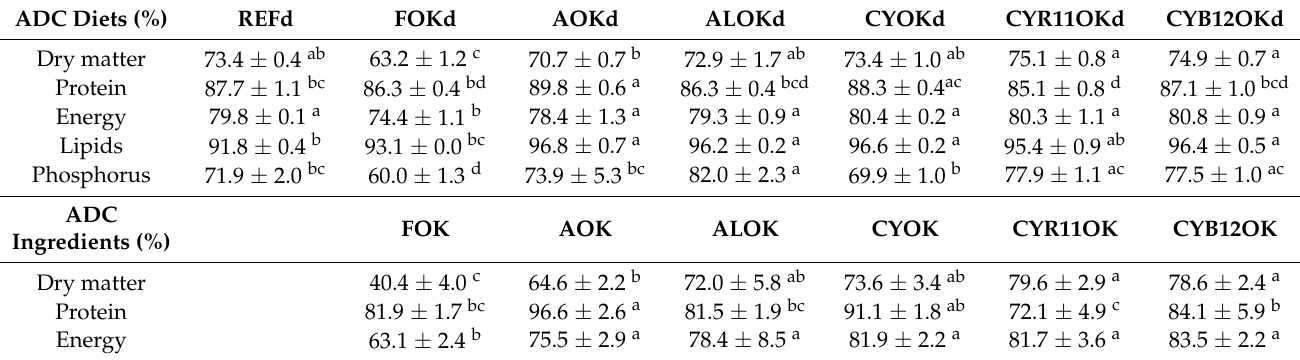
Table 5. Apparent digestibility coefficients (ADCs) of diets and test